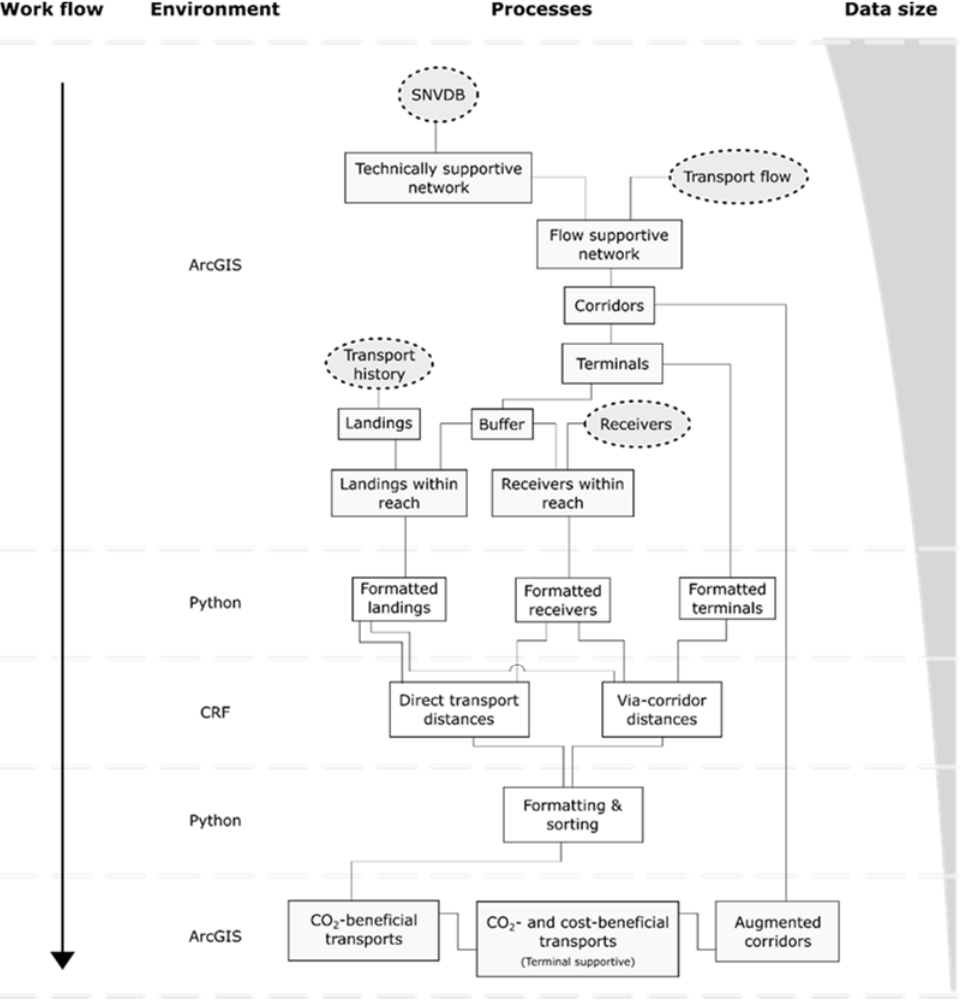
Figure 1. Schematic workflow of the study method, environment used, processes and data size. Ellipses are input data, rectangles are process ‐ derived results.